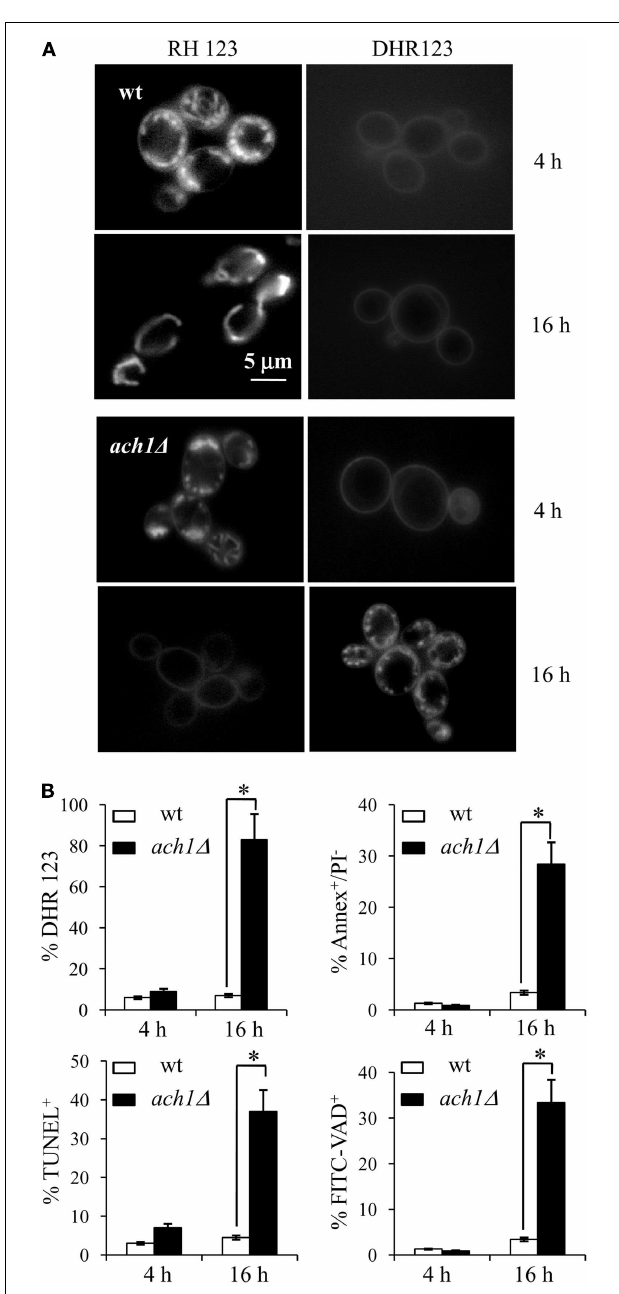
FIGURE 5 |The presence of acetic acid induces apoptosis in ach1 ∆ cells. Wild type and ach1 ∆ cells exponentially growing on 2% glucose were shifted to acetate (50mM) medium, pH 4.5 as sole carbon source. At the indicated time-points after the shift, cells were stained with Rhodamine 123 (RH123) to visualize functional mitochondria and with DHR123 for the presence of intracellular ROS (A) . Representative images are shown. Bar: 5 µ m.The same cultures were analyzed for apoptotic markers by Annexin V/PI co-staining andTUNEL assay, and for caspase activity by FITC-VAD-fmk. Summary graphs of the percentage of ROS-accumulating cells, of AnnexinV + /PI − , ofTUNEL + and FITC-VAD + are reported (B) . Evaluation of about 500 cells for each sample in three independent experiments was performed. Standard deviations are indicated. Statistical significance between the strains is indicated ( ∗ P ≤ 0.001, Student’s t